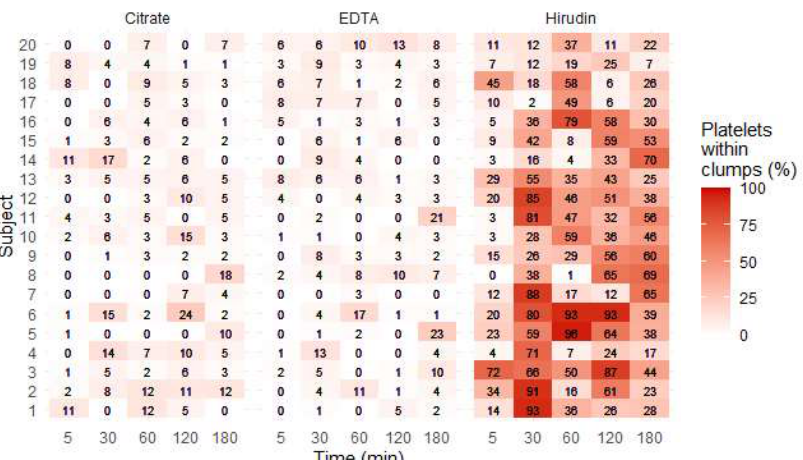
Figure 6. Percentage of platelets within clumps (%) for each subject, at each time point and for each anticoagulant.